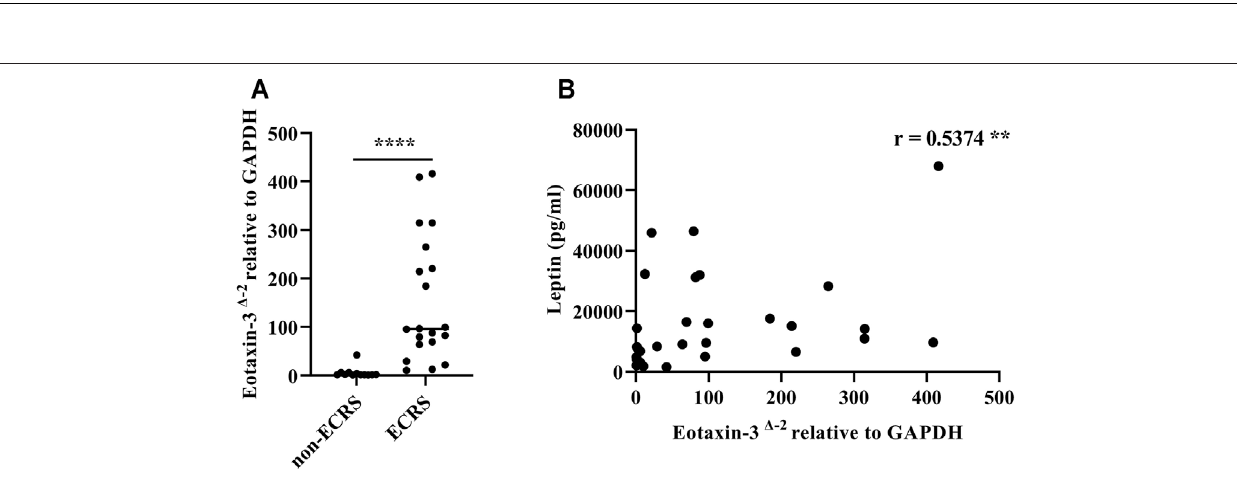
Frontiers in Pharmacology |